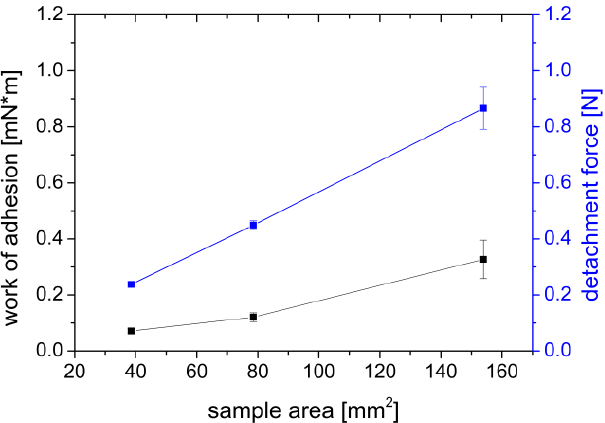
Figure 3. Effect of sample area of a PVA film on the work of adhesion (mN × m) and the detachment force (N) measured on a gel of 2% agar and 4% mucin. Mean ± SD, n = 6.